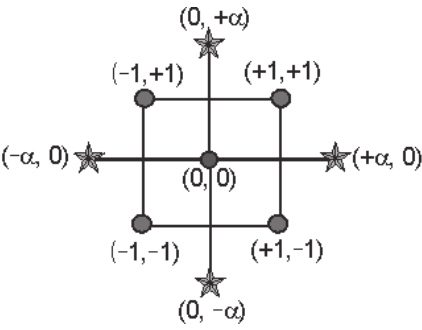
Figure 5. Circumscribed central composite design (CCD) sample points.